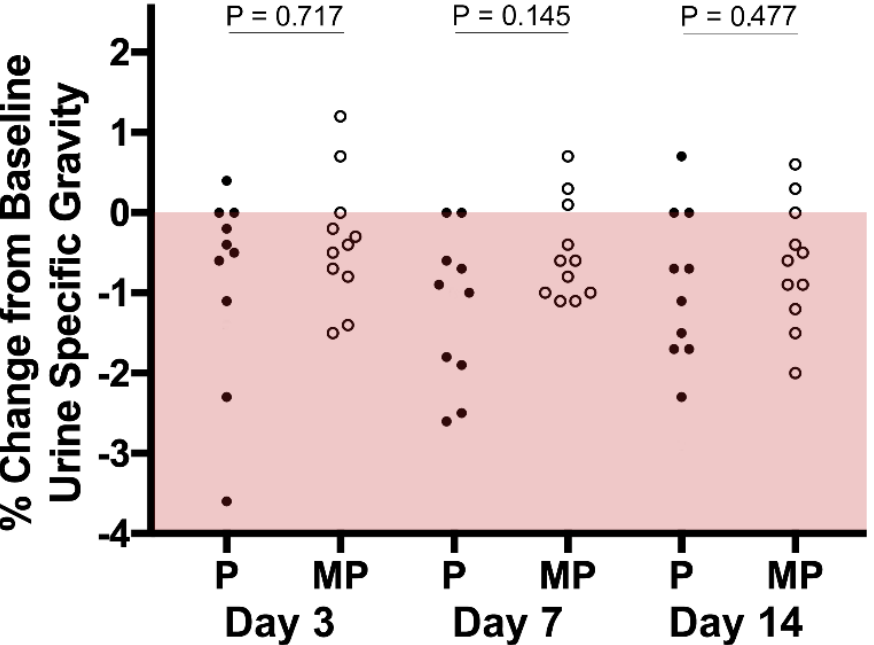
Figure 2. Percentage change from baseline urine specific gravity. The pink area indicates no change or decreases in USG.